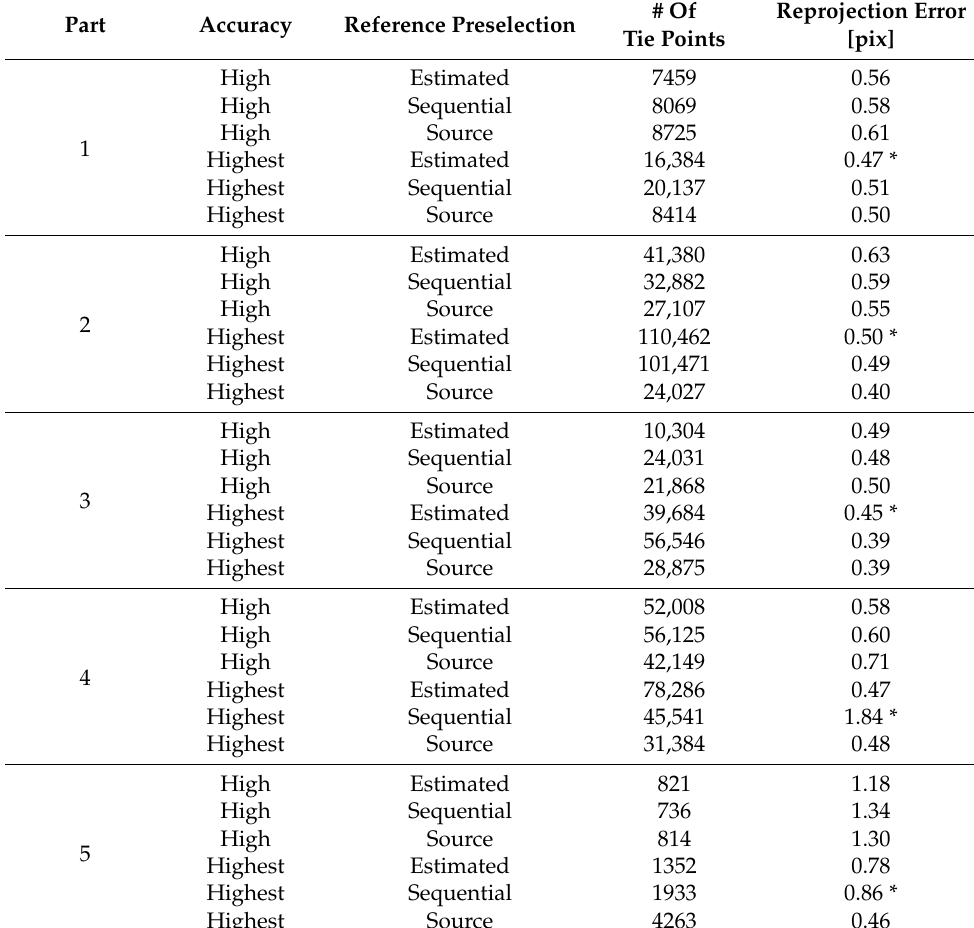
Table 4. DJI Matrice 300 RTK thermal photos alignment results.